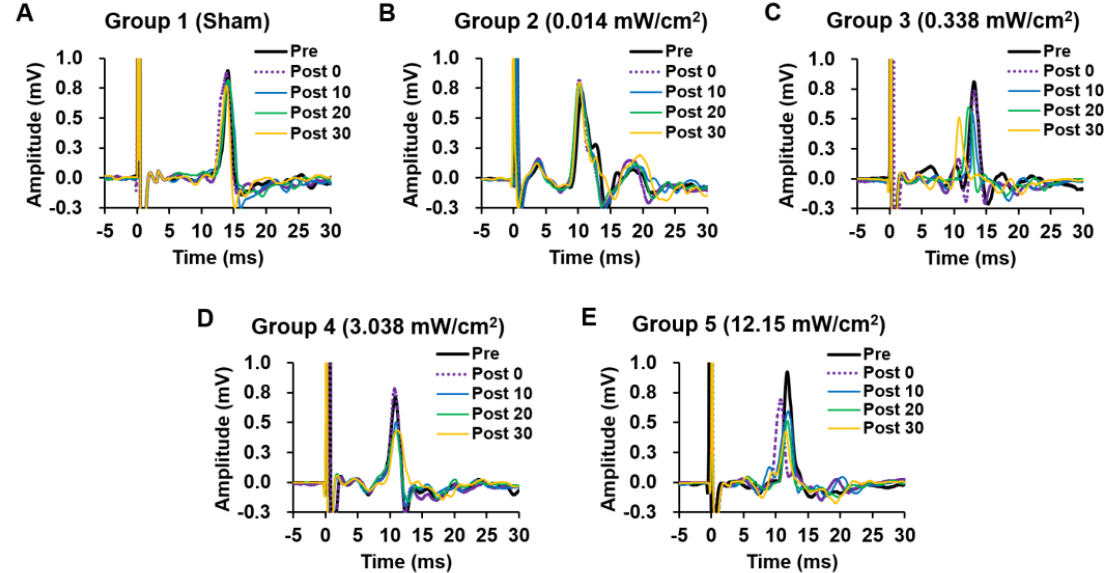
Figure 1. Representative MEPs of a rat before and after sham stimulation with various intensities of tFUS are presented at each measured period (preintervention and 0, 10, 20, 30 min after tFUS) with a colored line. ( A ) The MEPs of the right limb for each time point after sham treatment ( B ) The MEPs of the right limb for each time point after I SPTA of 0.014 mW/cm 2 ( C ) The MEPs of the right limb for each time point after I SPTA of 0.338 mW/cm 2 ( D ) The MEPs of the right limb for each time point after I SPTA of 3.038 mW/cm 2 ( E ) The MEPs of the right limb for each time point after I SPTA of 12.15 mW/cm 2 .